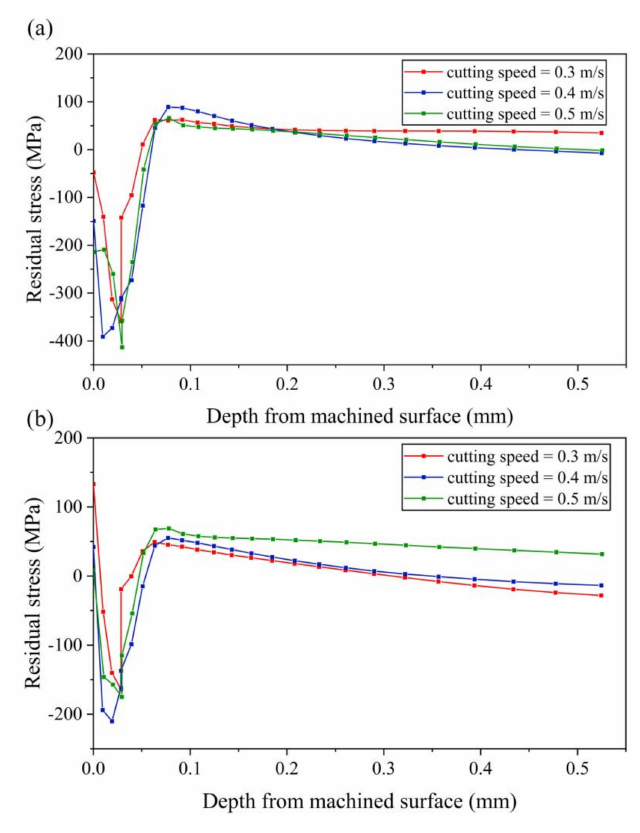
Figure 12. Results of residual stress with various cutting speeds ( a ) stress-xx ( b )